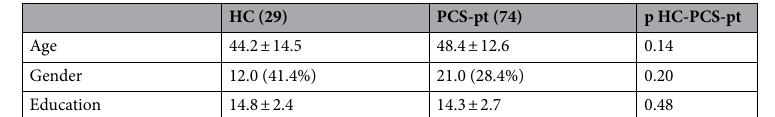
Table 1. Comparison of demographic data between PCS-pt and HC. Reported p values are from Mann– Whitney U-test for Age and Education and from the Chi square test for Gender. pt patients, HC healthy controls, PCS post COVID-19